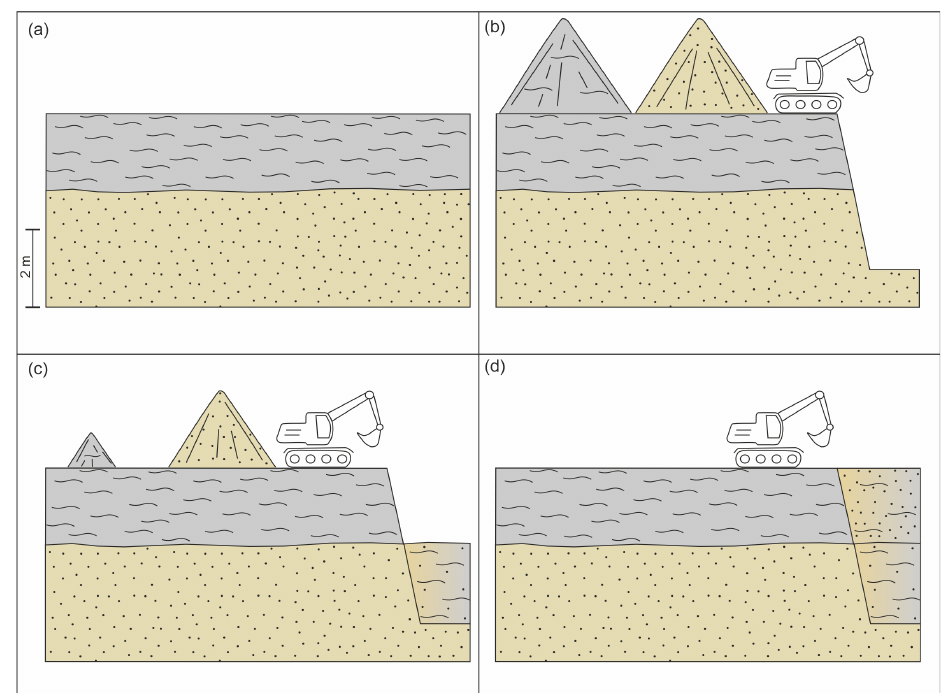
Figure 12. Outline of the stages of the agricultural practice of “turning”. ( a ) sandy deposits to be replaced are shown in light brown while clayey deposits are shown in grey; ( b ) removal of the superficial layers; ( c ) the lower part of the excavation is filled with a mixture of predominantly clay and clayey sand; ( d ) the upper part of the excavation is filled with a mixture of predominantly sandy clay and sand.